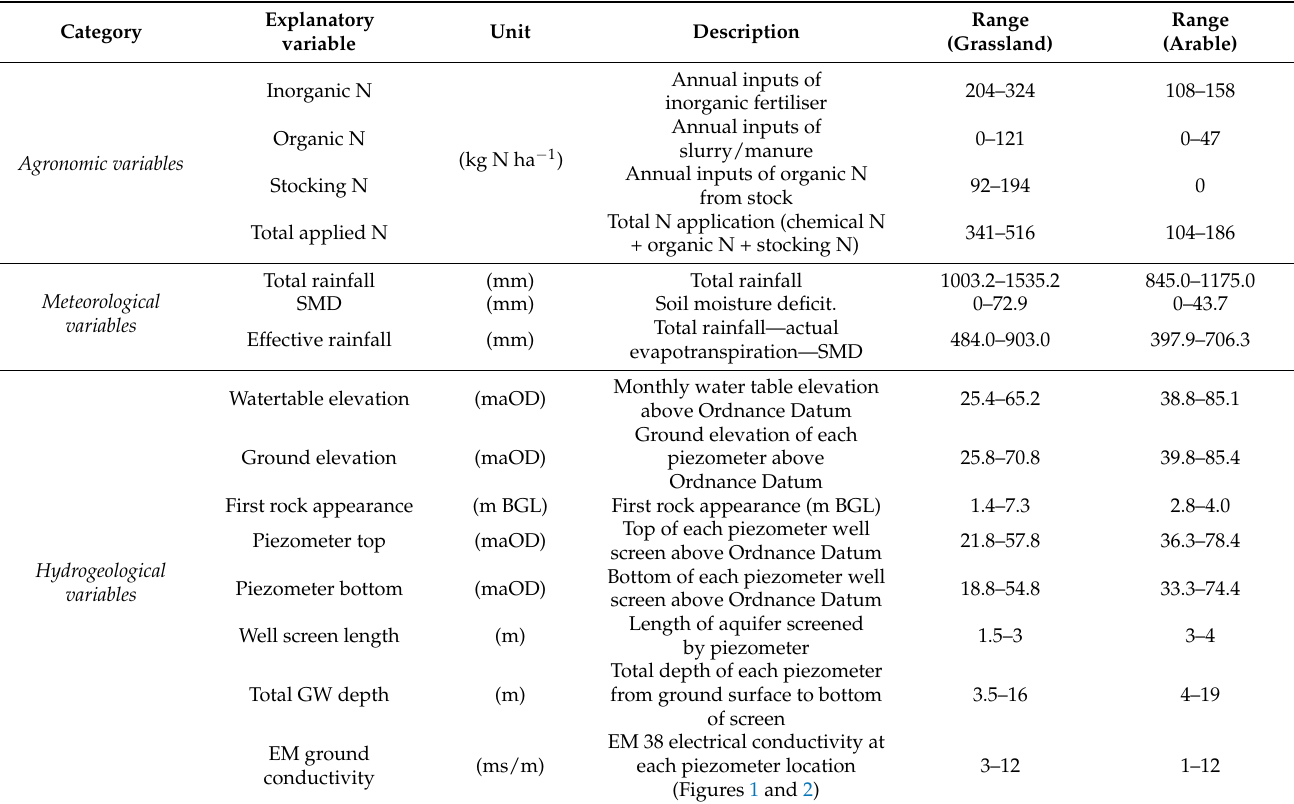
Table 4. Agronomic, meteorological and hydrogeological variables interrogated in the